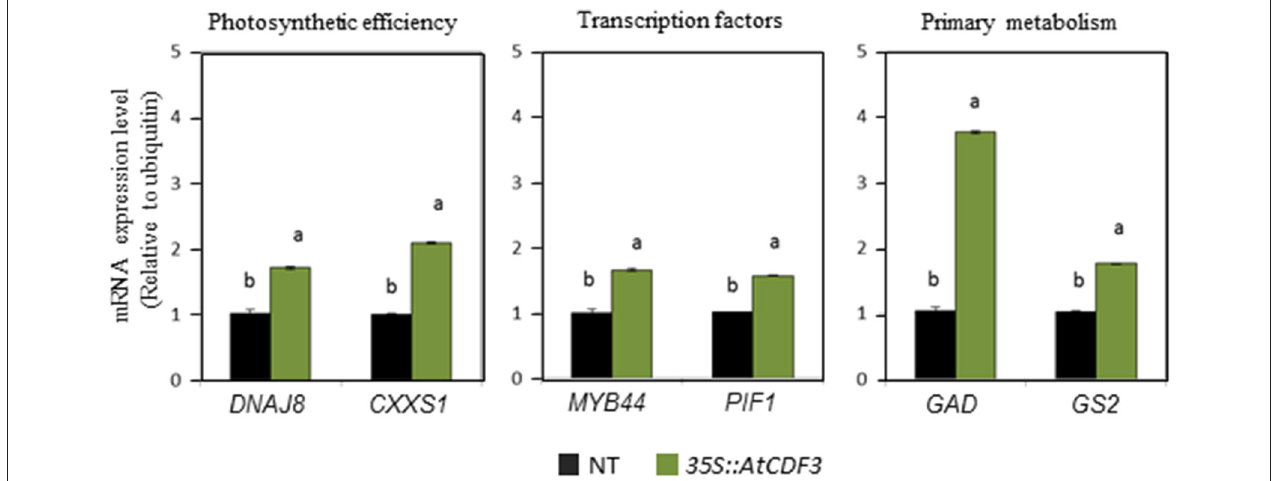
FIGURE 3 | AtCDF3 regulates the expression of genes involved in photosynthesis, primary metabolism and growth-and stress- related transcription factors. Transcription analysis by RT-qPCR of genes DNAJ8 , CxxSl , MYB44 , PIFl , GAD , and GS2 in the leaves of the 35S::AtCDF3 (green bars) and NT (black bars) tomato plants grown under the control conditions for 30 days. UBIQUITIN3 gene expression was used as the reference gene. Data are expressed as mean ± SE of three independent extractions. Three technical replicates were performed for each extraction. For each gene, different letters indicate significant differences ( P < 0.05).